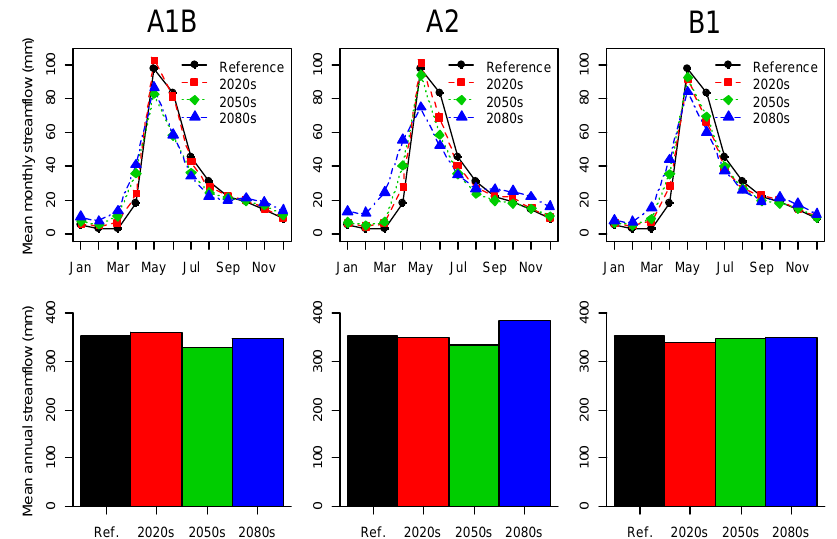
Fig. 8. HBV-EC-simulated mean monthly and mean annual streamflows for the reference and nine future periods (for three different scenarios: A1B, A2 and B1; and for three different time periods: 2020s, 2050s and 2080s) at the watershed outlet at Crowsnest at Frank. Both reference and future period inputs to the HBV-EC is the daily climate data generated by LARS-WG. Table 3. Modules, description of calibrated parameters, calibrated parameter values and ranges of the 100 best parameter sets. Model